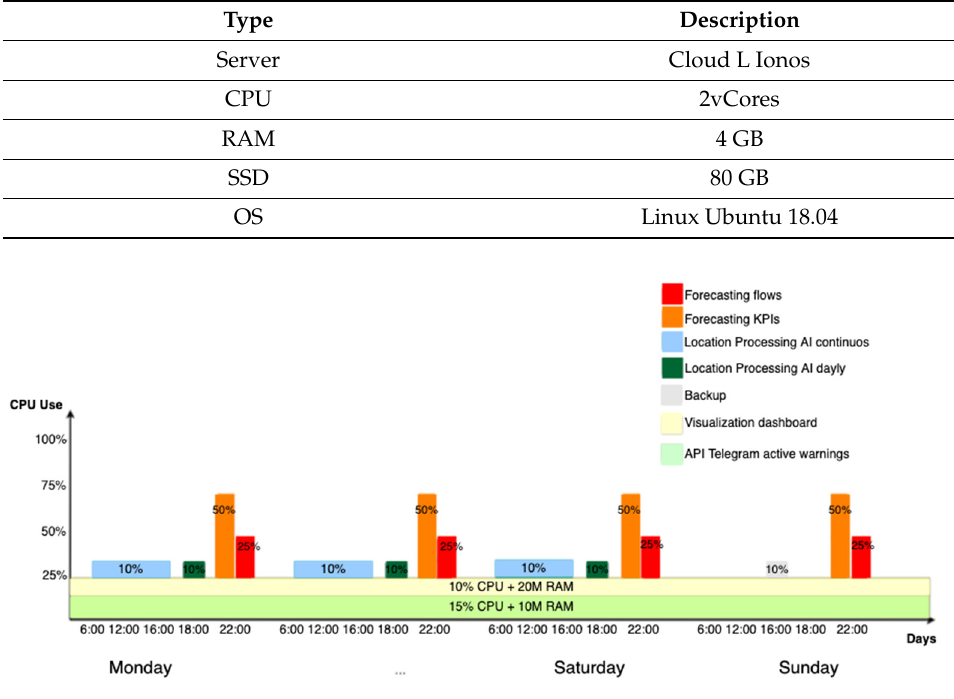
Figure 5. CPU usage of the server in real deployment.